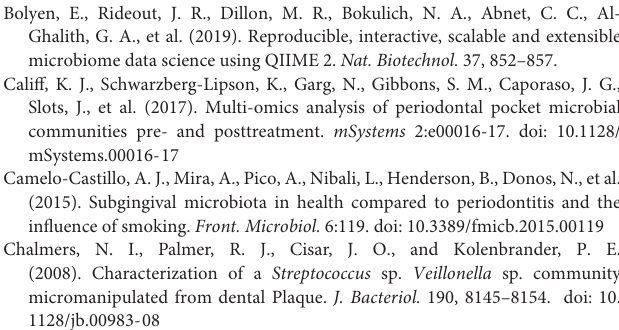
Supplementary Figure 3 | Beta dispersion analysis by periodontal treatment, response to treatment, and disease class. For the PT study, distance from the